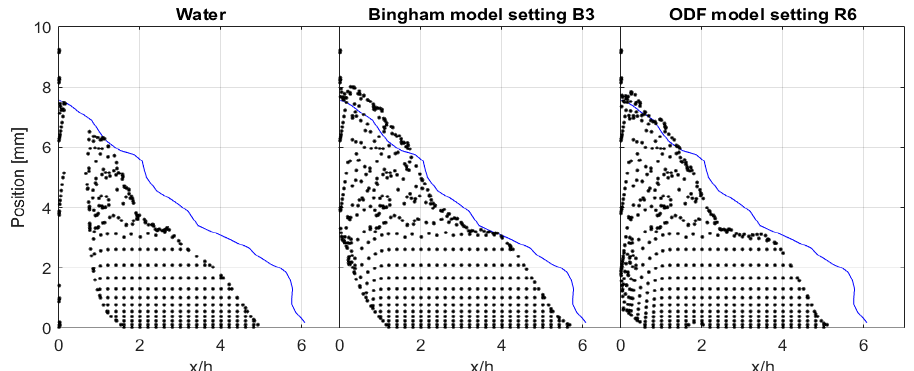
Figure 7. Computed recirculation zones for simulations with pure water ( left ), the Bingham model ( middle ) and the ODF model ( right ), plotted with the experimental recirculation zone curve for 1.5% fibres from Claesson (2012) [24].